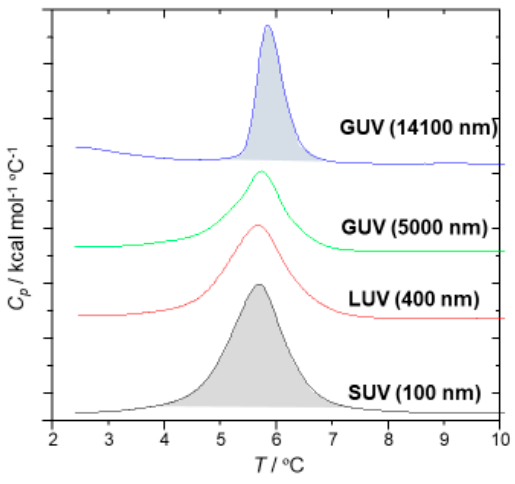
Figure 6. DSC profiles of SOPC vesicles.